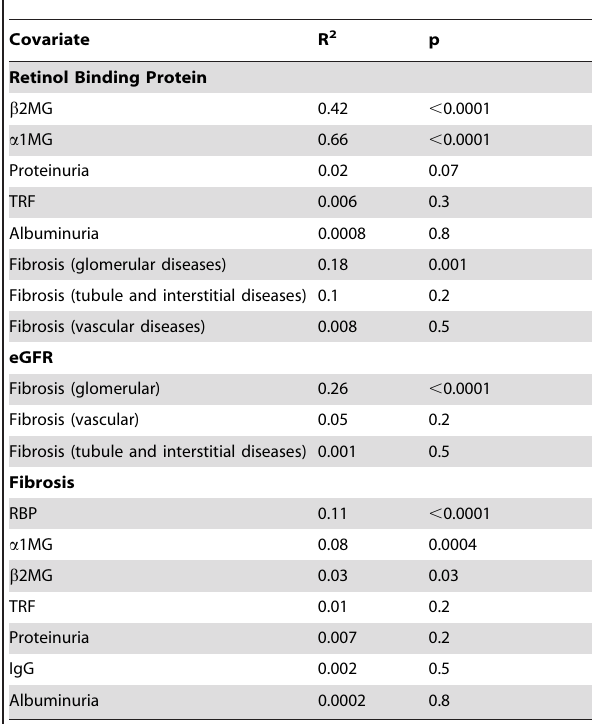
Table 2. Summary of correlative data.